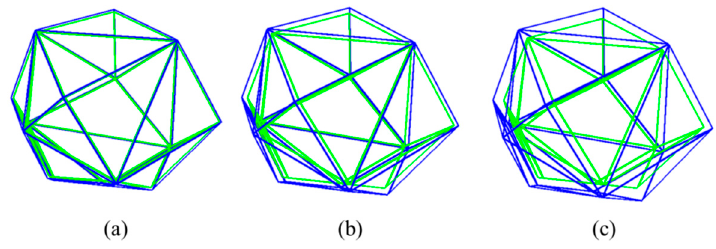
Figure 7. Geometry outlines of di ff erent ITZ layers: ( a ) 0.1 mm thickness η = 0.05, ( b ) 0.25 mm thickness η = 0.125, ( c ) 0.5 mm thickness η = 0.25.